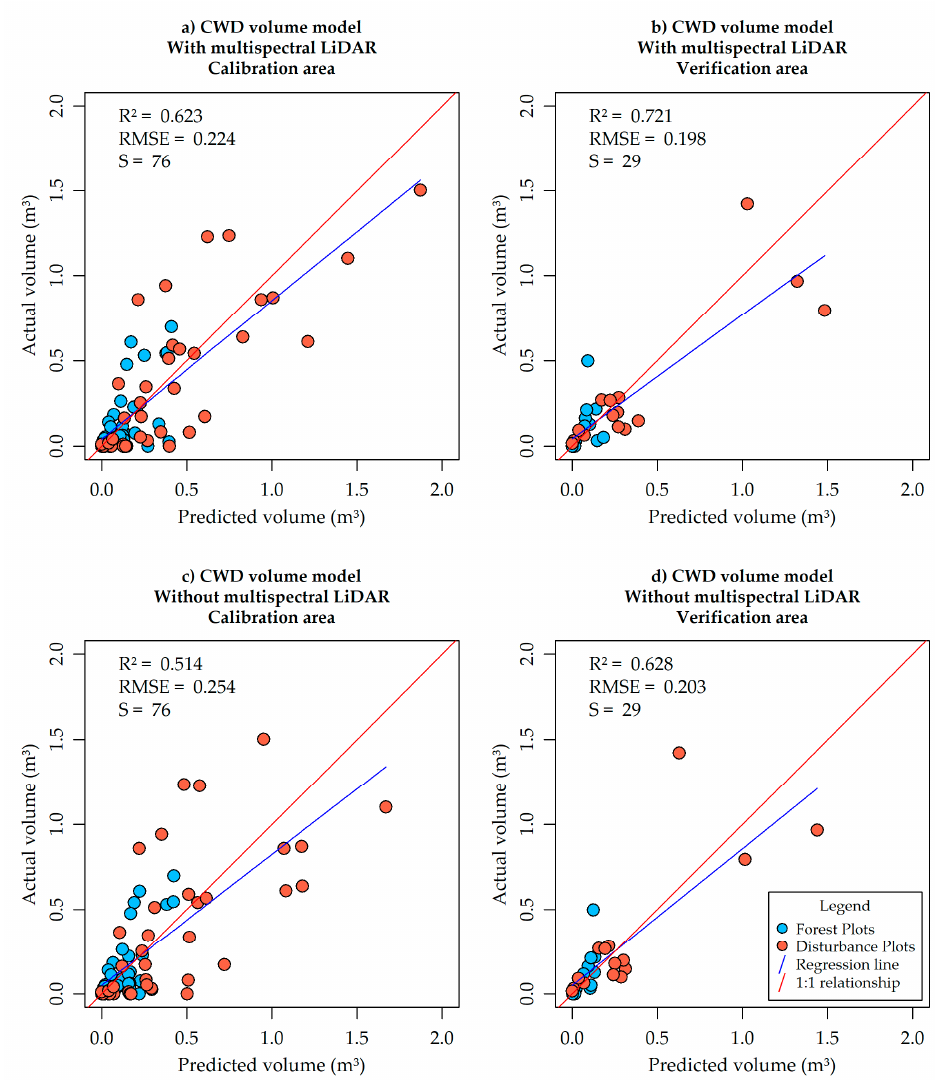
Figure 3. Scatter plots of actual versus predicted coarse woody debris (CWD) volume in m 3 . The best model with multispectral LiDAR (ML) data was used to estimate CWD volume on ( a ) the calibration area plots using keep-one-out cross-validation, and on ( b ) the verification area plots using the calibration plots to train the model. Similarly, the best model without ML data was also applied to the ( c ) calibration and ( d ) verification areas. Goodness-of-fit (R 2 ), root mean square error (RMSE) and sample size (S) are indicated on each plot.